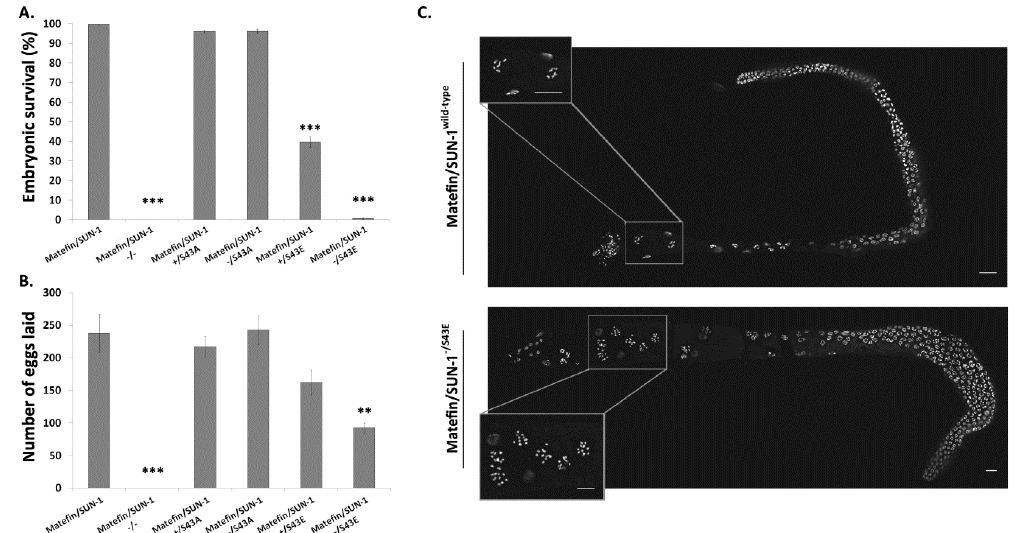
Figure 7. Constitutive expression of matefin/SUN ‐ 1 pS43 reduces animal fertility. Expression of S43E matefin/SUN ‐ 1 led to reduced: ( A ) embryonic viability. p ‐ values: matefin/SUN ‐ 1 − / − = 1.74 × 10 − 23 ; matefin/SUN ‐ 1 +/S43E = 1.17 × 10 − 8 ; matefin/SUN ‐ 1 − /S43E = 1.18 × 10 − 20 ; ( B ) total number of egg laid. p ‐ values: matefin/SUN ‐ 1 − / − = 2.7 × 10 − 5 and matefin/SUN ‐ 1 − /S43E = 0.003. Error bars represent SEM. * p < 0.05, ** p < 0.005, *** p < 0.0005 as compared to wild ‐ type; ( C ) DAPI staining of gonads taken from animals expressing wild type matefin/SUN ‐ 1:GFP ( top panel ) and matefin/SUN ‐ 1 − /S43E ( bottom panel ). Matefin/SUN ‐ 1 pS43 expression prevents the formation of bivalents during diakinesis. Enlarged boxes show diakinesis nuclei. Scale bar 10 μ m.